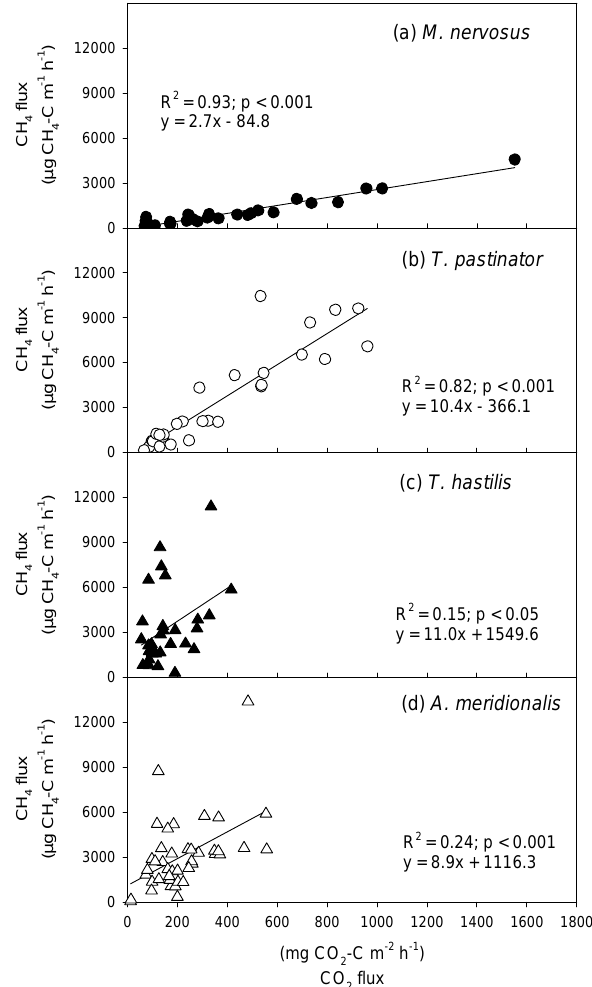
Fig. 3. Simple linear regression analysis between CH 4 and CO 2 fluxes from the mounds of four termite species. The Mann–Whitney U test showed that slope of M. nervosus mounds was significantly different from the mounds of T. pastinator (p ≤ 0 . 01), T. hastilis ( p ≤ 0 . 01 ) and A. meridionalis ( p ≤ 0 . 01).